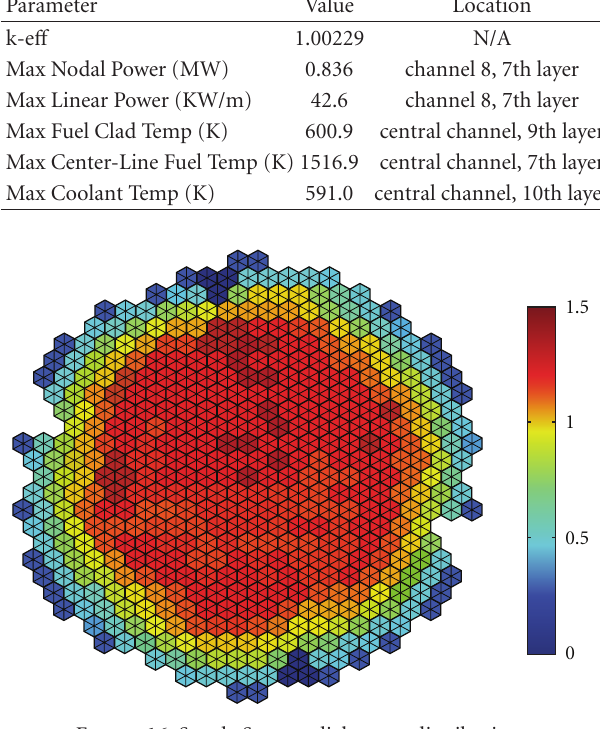
Figure 16: Steady State: radial power distribution.